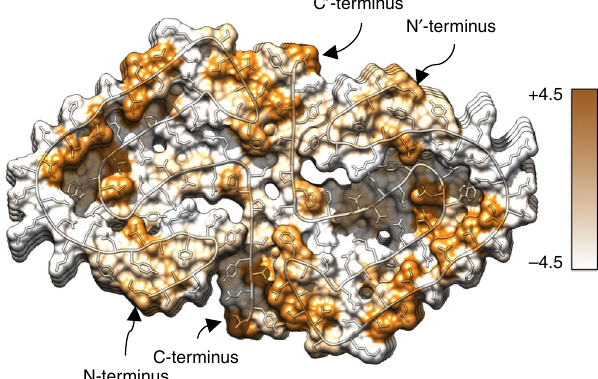
Fig. 3 Secondary structure comparison of the PI3K-SH3 DF fi bril. Secondary structure of the presented cryo-EM structure compared to data obtained previously by solid-state NMR ( fi brils) or liquid-state NMR (monomeric, native state). a Tilted cross-section of four SH3 DF fi bril layers. Secondary structure is predominantly formed by seven cross- β sheets. b Secondary structure comparison to the native solution structure (PDB: 1PKS 28 ) and ssNMR results ( fi brils) modi fi ed according to Bayro et al. 38 . Flexible regions are shown as dashed lines, β -sheets as arrows, and the helix as a cylinder